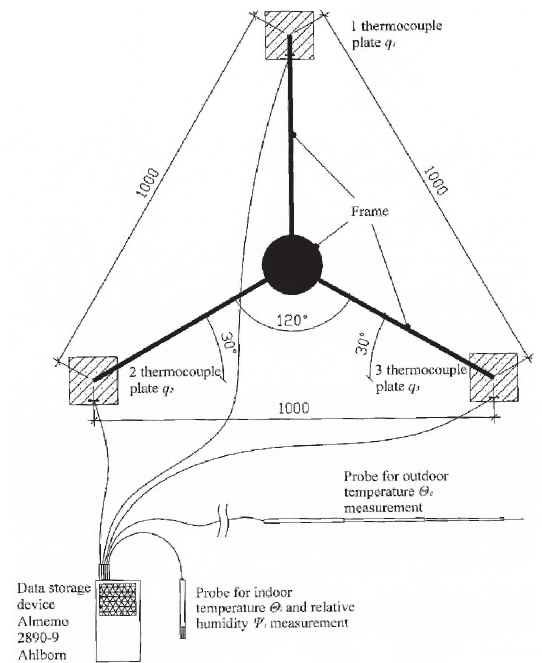
Fig. 4. Principal scheme for measuring heat fluxes of the walls Fig. 5. Heat transfer coefficients recorded before and after